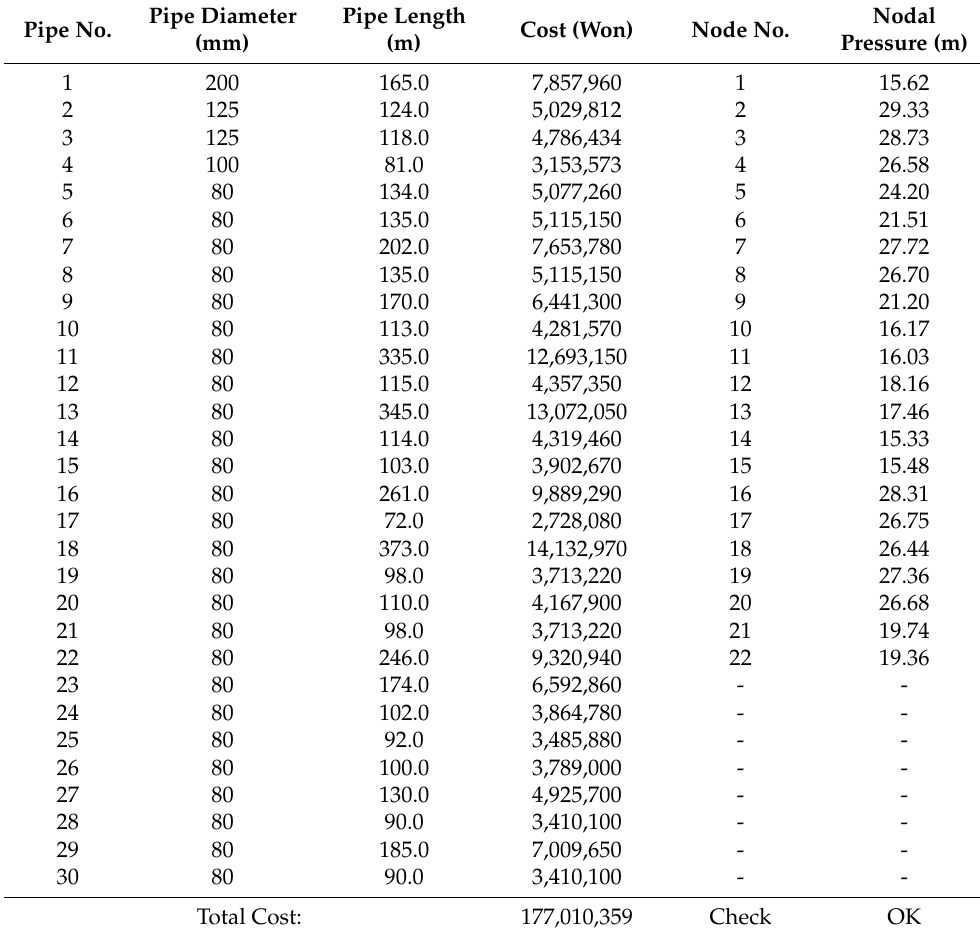
Table 11. SOP–WDN results for the GoYang network. Pipe